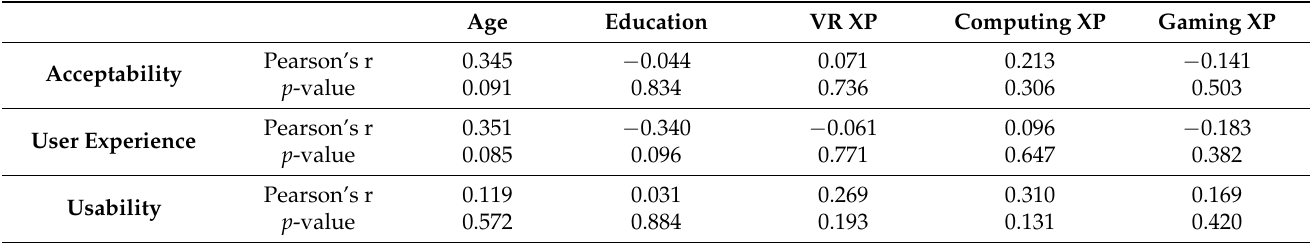
Table 2. Pearson’s correlations between demographics and